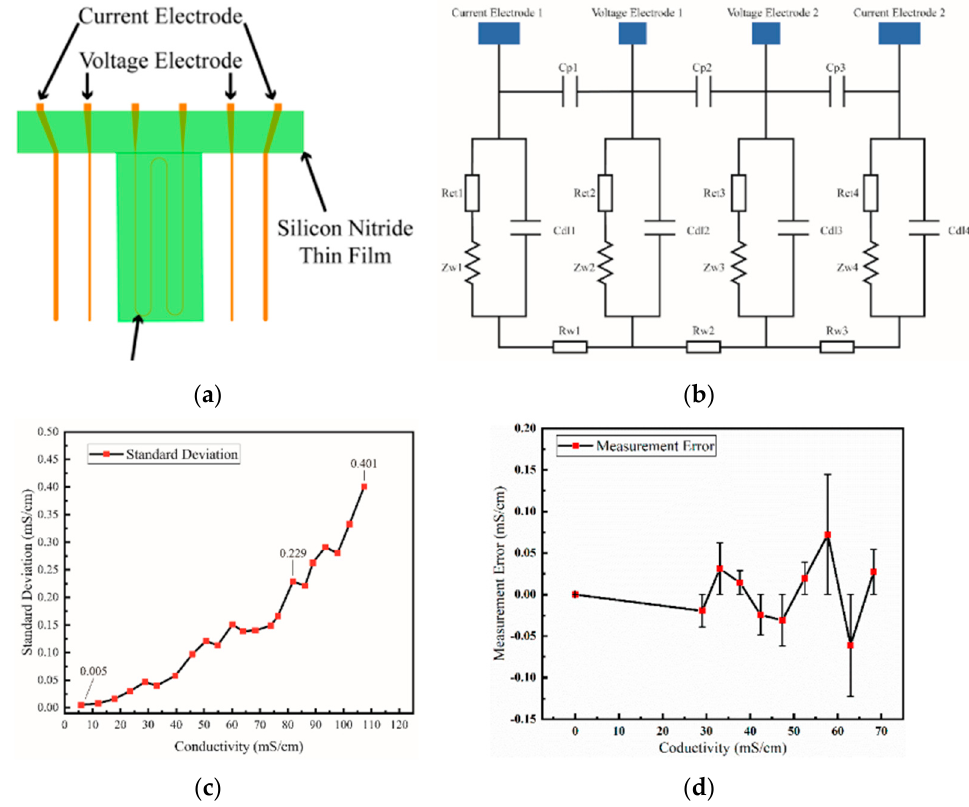
Figure 2. Four − electrode conductivity sensor: ( a ) chip structure; ( b ) equivalent circuit diagram; ( c ) result of measuring precising; ( d ) measurement error.